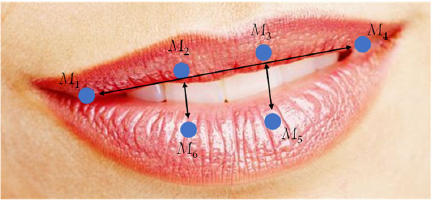
Figure 3. Key points selected around the mouth for calculating MAR.